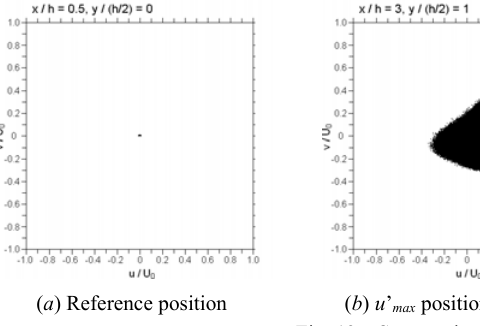
Fig. 13 Scatter plots on u - v plane.